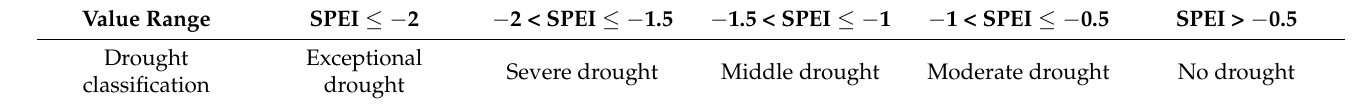
Table 1. The ranking division standard of the standardized precipitation evapotranspiration in- dex